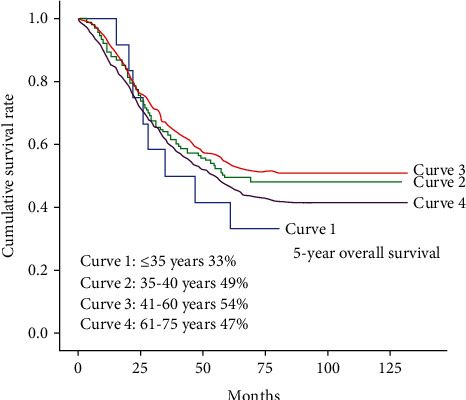
Survival curves among all the patients in four subgroups. The Kaplan–Meier Gastric Cancer survival curve based on significant prognostic predictors for overall survival in the study group patients. Survival curves among all the patients of four subgroups, which are age ≤35 years (Curve 1), age 35-40 years (Curve 2), age 41-60 years (Curve 3), and age 61-75 years (Curve 4). There was a significant difference in survival between Curve 3 and Curve 4 (P = 0.007). There was no significant difference in survival between other curves. The 5-year overall survival rates with respect to the young, middle, and old age group were 46%, 48%, and 39%, respectively, but when we tally the subgroups of the young age with each other, the result shows a marked variation in the overall 5-year survival rate with respect to that of subgroup A and subgroup B with 33% and 49% survival outcomes.